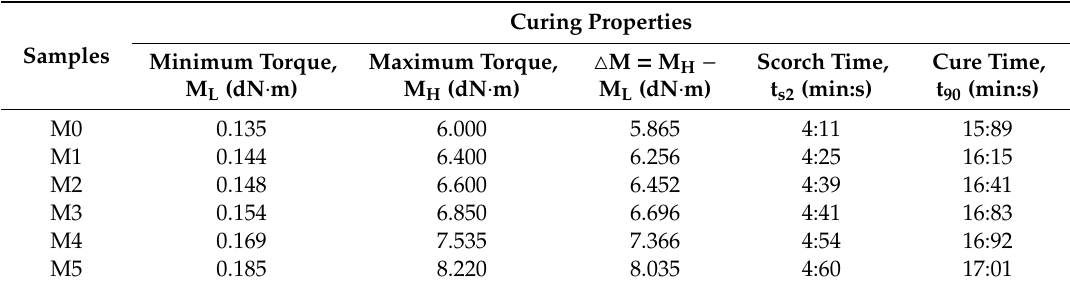
Table 2. Curing properties of the silica / rubber